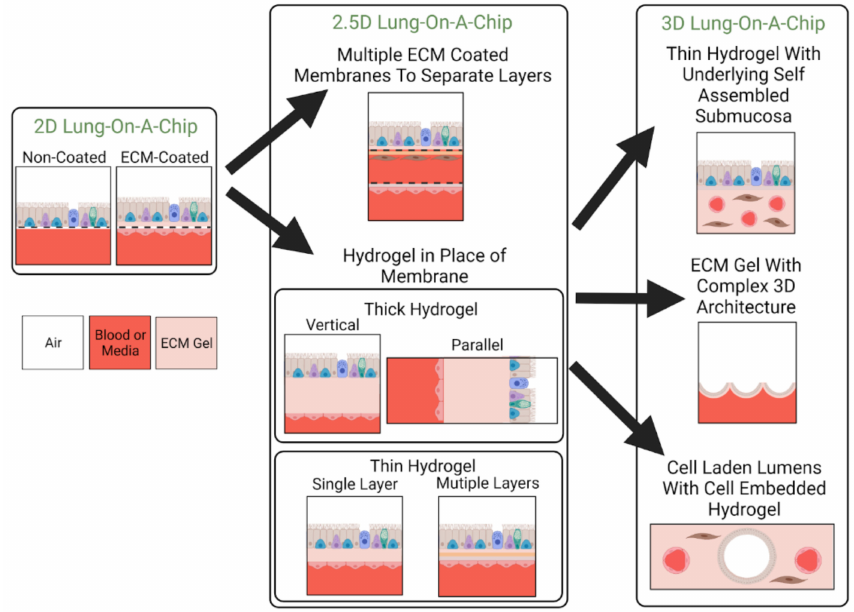
Figure 4. Classification of Lung-On-A-Chip Device Based on ECM Dimensionality. Lung-on-a-chip devices can be made to incorporate ECM substitutes of varying dimensionality. The selected ECM substitute dictates the 3D organization of cellular components as well as how close the model can replicate the native ECM. Here, 2D, 2.5D, and 3D refer to the dimensionality of the incorporated ECM substitute. Devices containing 2D ECM substitutes contain porous membranes that are either left uncoated or are coated with ECM proteins. 2.5D lung-on-a-chip devices either use multiple ECM coated membranes to achieve multilayer stratification or incorporate a hydrogel in place of the membrane to replicate the structure and composition of its native counterpart. Hydrogels can be thin or thick and composed of single layers or multiple layers of ECM material. 3D lung-on-a-chip devices achieve structures more similar to the in vivo setting by incorporating cellular components into the bulk of a hydrogel to obtain 3D cellular organization or creating complex 3D architecture for epithelium. These structures can include alveoli-like pockets or cell-lined